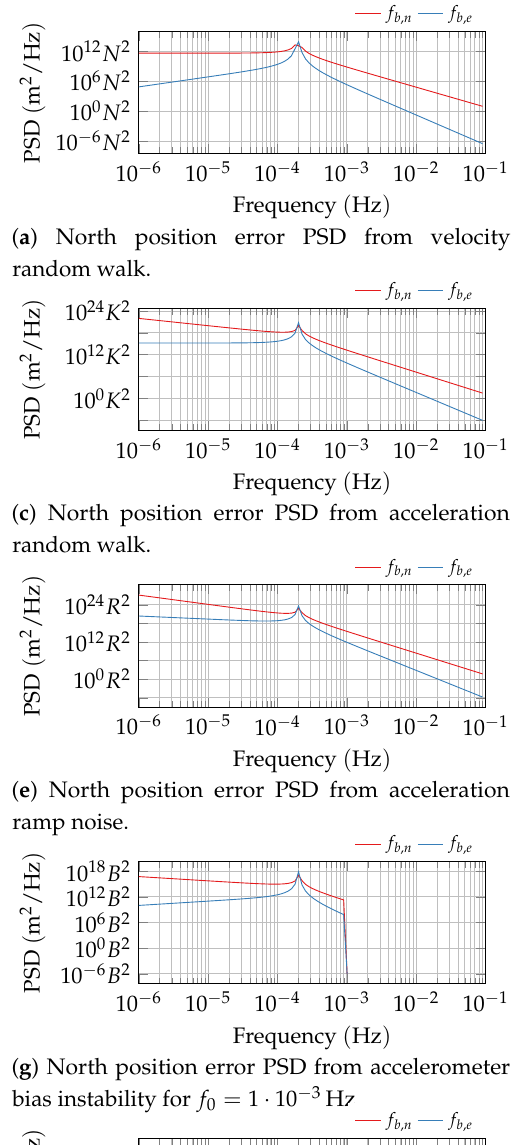
bias instability for f 0 = 1 · 10 − 3 Hz.